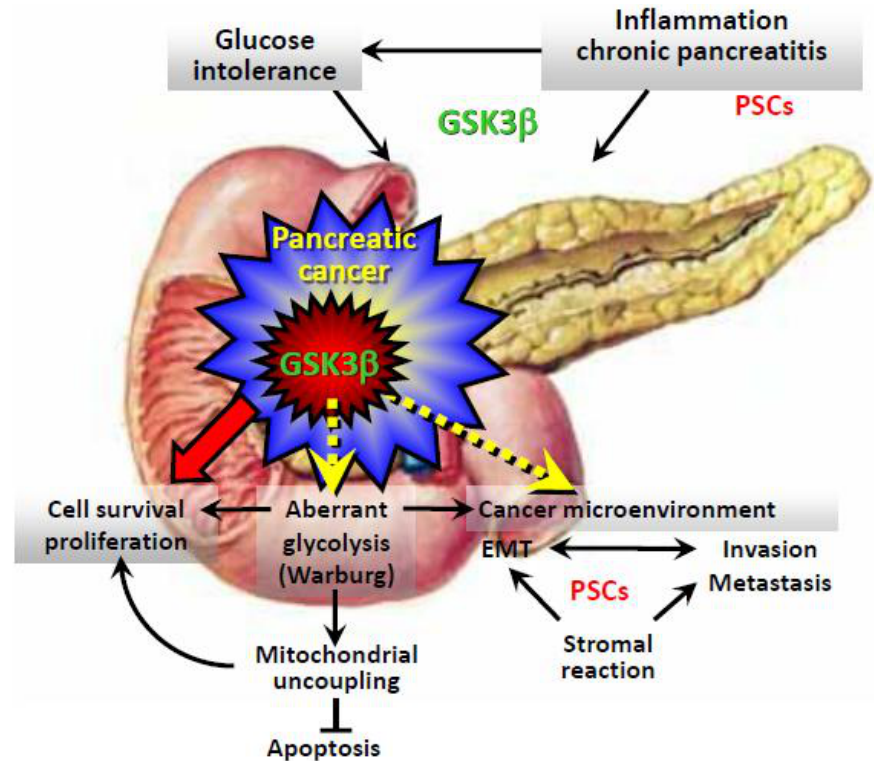
Figure 3. Systemic and local effects of aberrant GSK3β on risk factors (glucose intolerance and chronic inflammation) and progression of pancreatic cancer. Molecular mechanisms leading to the pathways indicated by the dotted arrows are not well